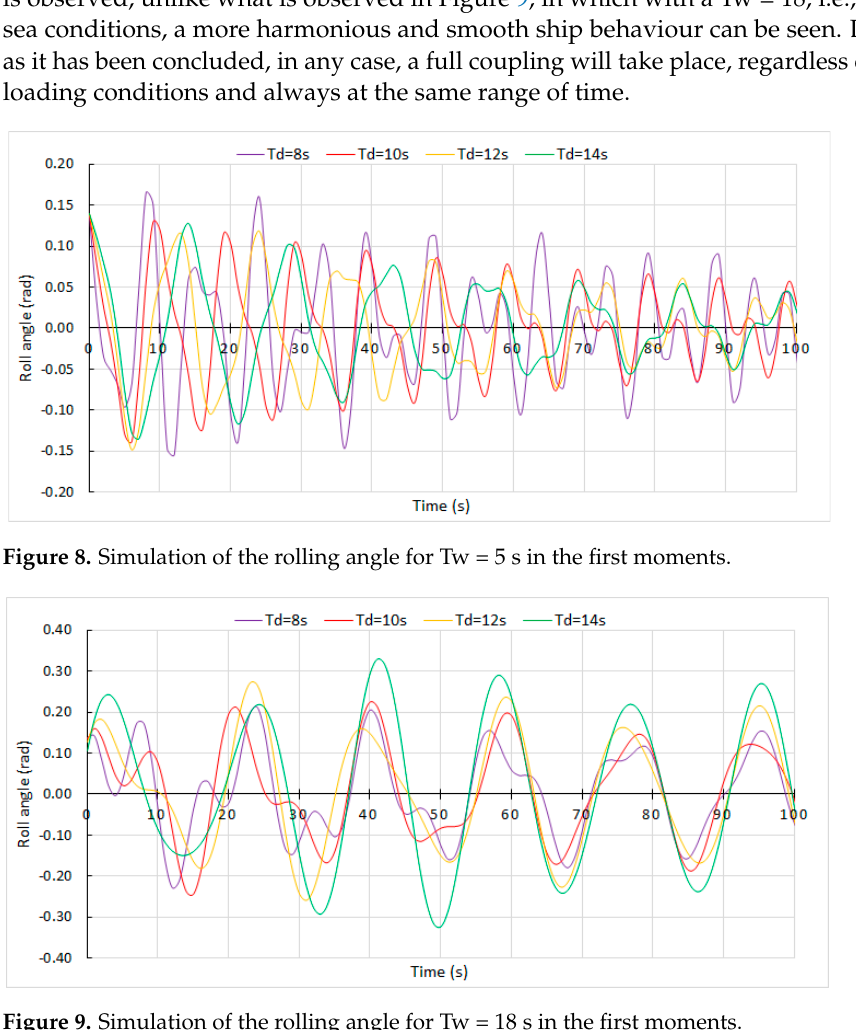
Figure 7. Rolling angles reached by di ff erent ship loading conditions for Tw = 11 s.